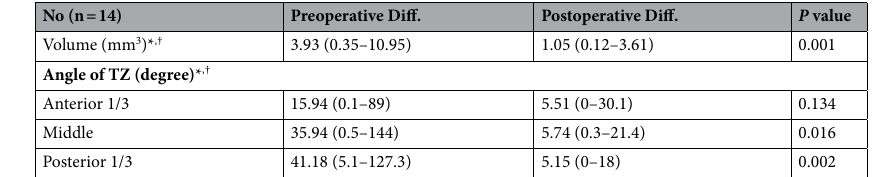
Table 4. Preoperative and postoperative measurements for the orbit. Diff difference of the affected and the unaffected eye, TZ transition zone of orbital buttress; *Mean, † Range.